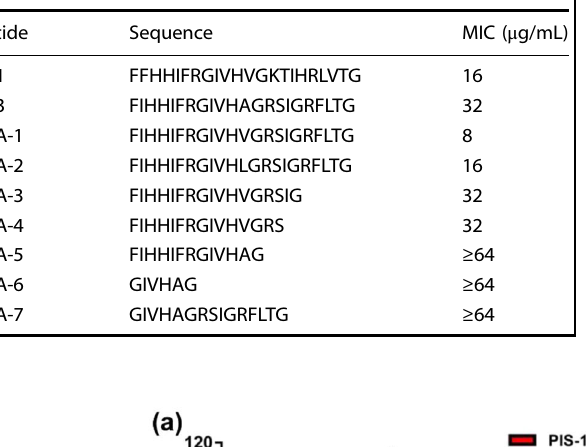
Table 1. Minimal inhibitory concentration of PIS-3 analogues against methicillin-resistant Staphylococcus aureus ATCC 43300.